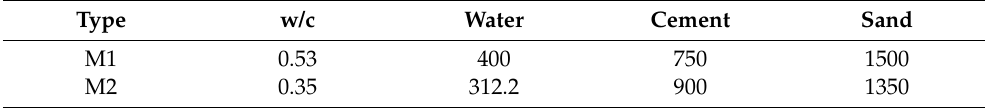
Table 3. Mixture proportions of